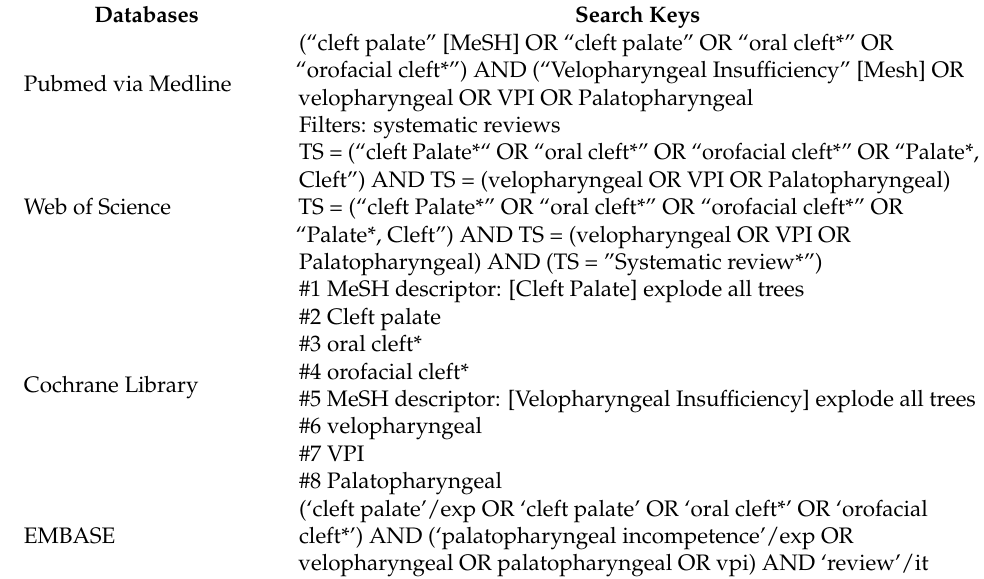
Table 2. Search keys in various